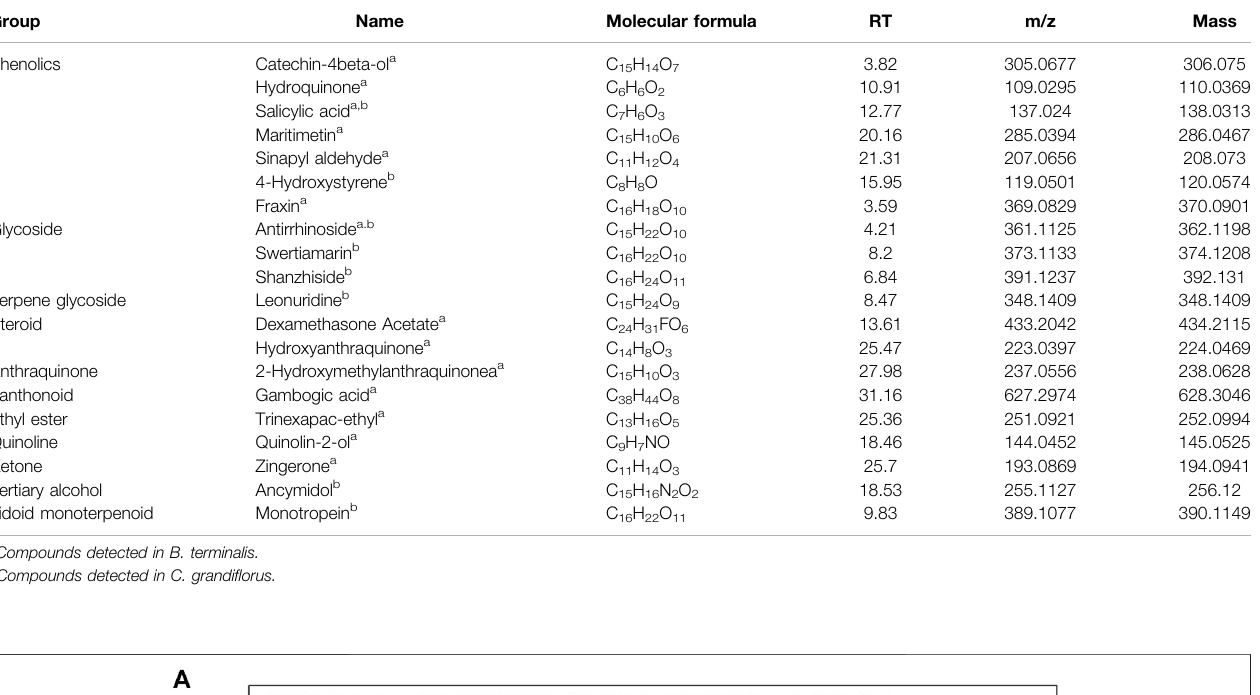
Table 2 . Anti-diabetic activity was analyzed by using α -amylase